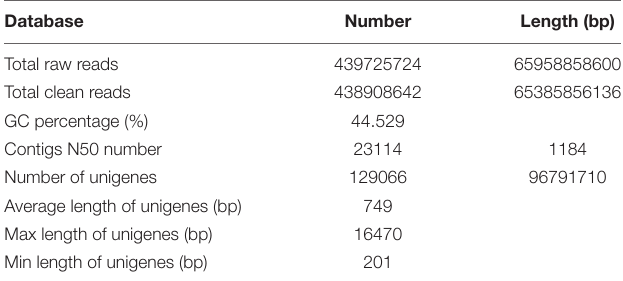
TABLE 2 | Summary of annotation of G. longipes